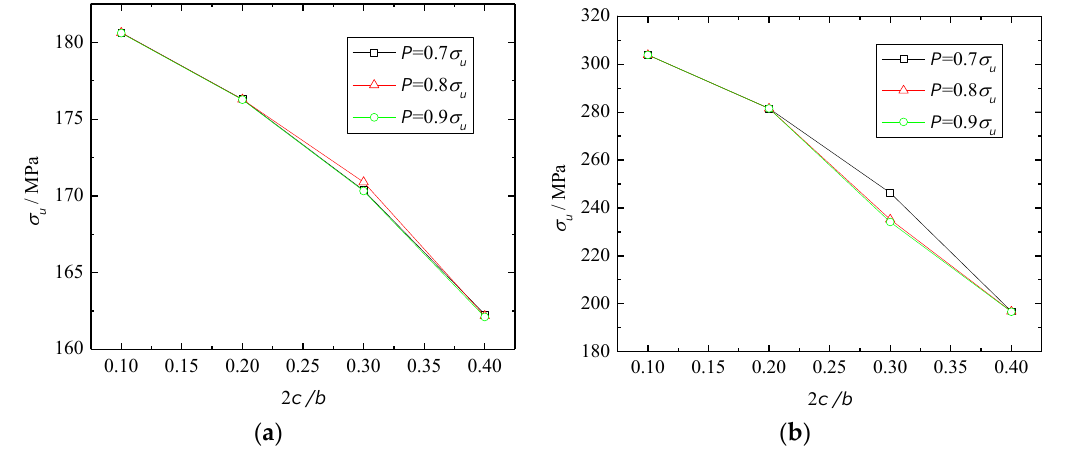
Figure 10. Residual strength at different cyclic load magnitudes: ( a ) compressive residual strength; ( b ) tensile residual strength.